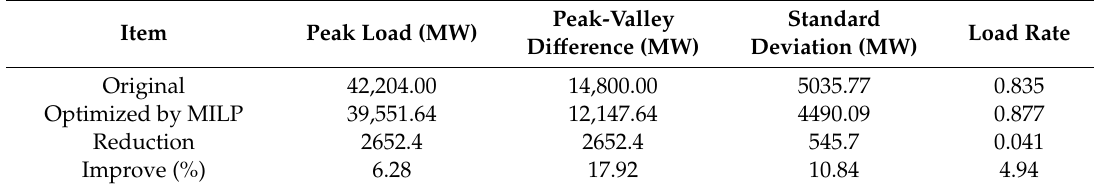
Table 3. Comparison of the original load and the optimized load obtained by mixed integer linear programming (MILP) in Case